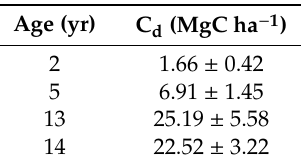
Table 2. Measured SOC Stocks Under ARRI Reclamation. Uncertainty reflects ± 1 SE.